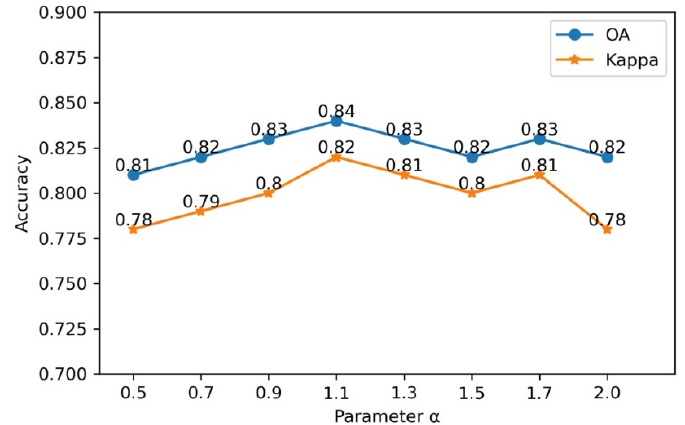
Figure 13. Parameter influence analysis with hyperparameter α .